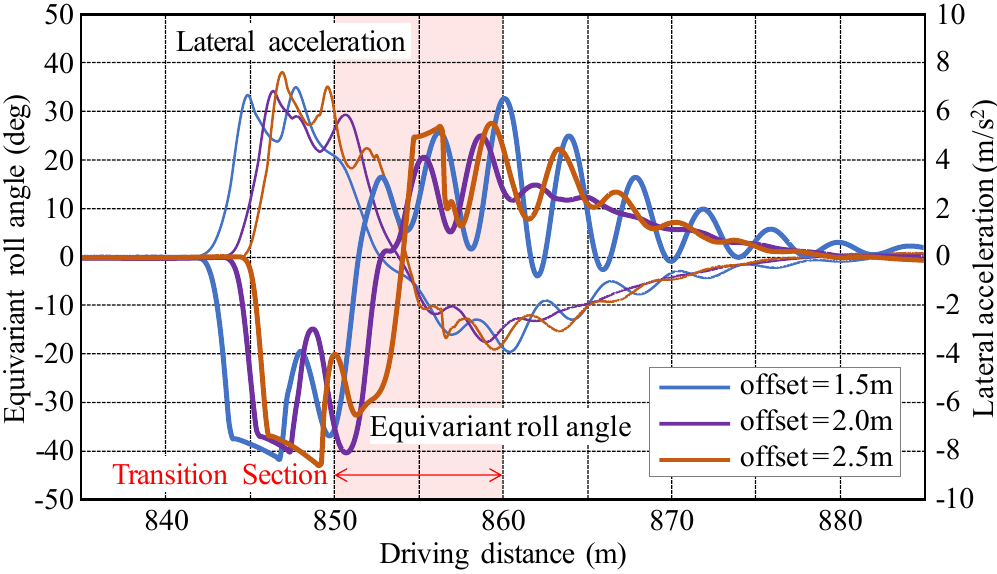
Figure 27. Balance of lateral acceleration and equivariant roll